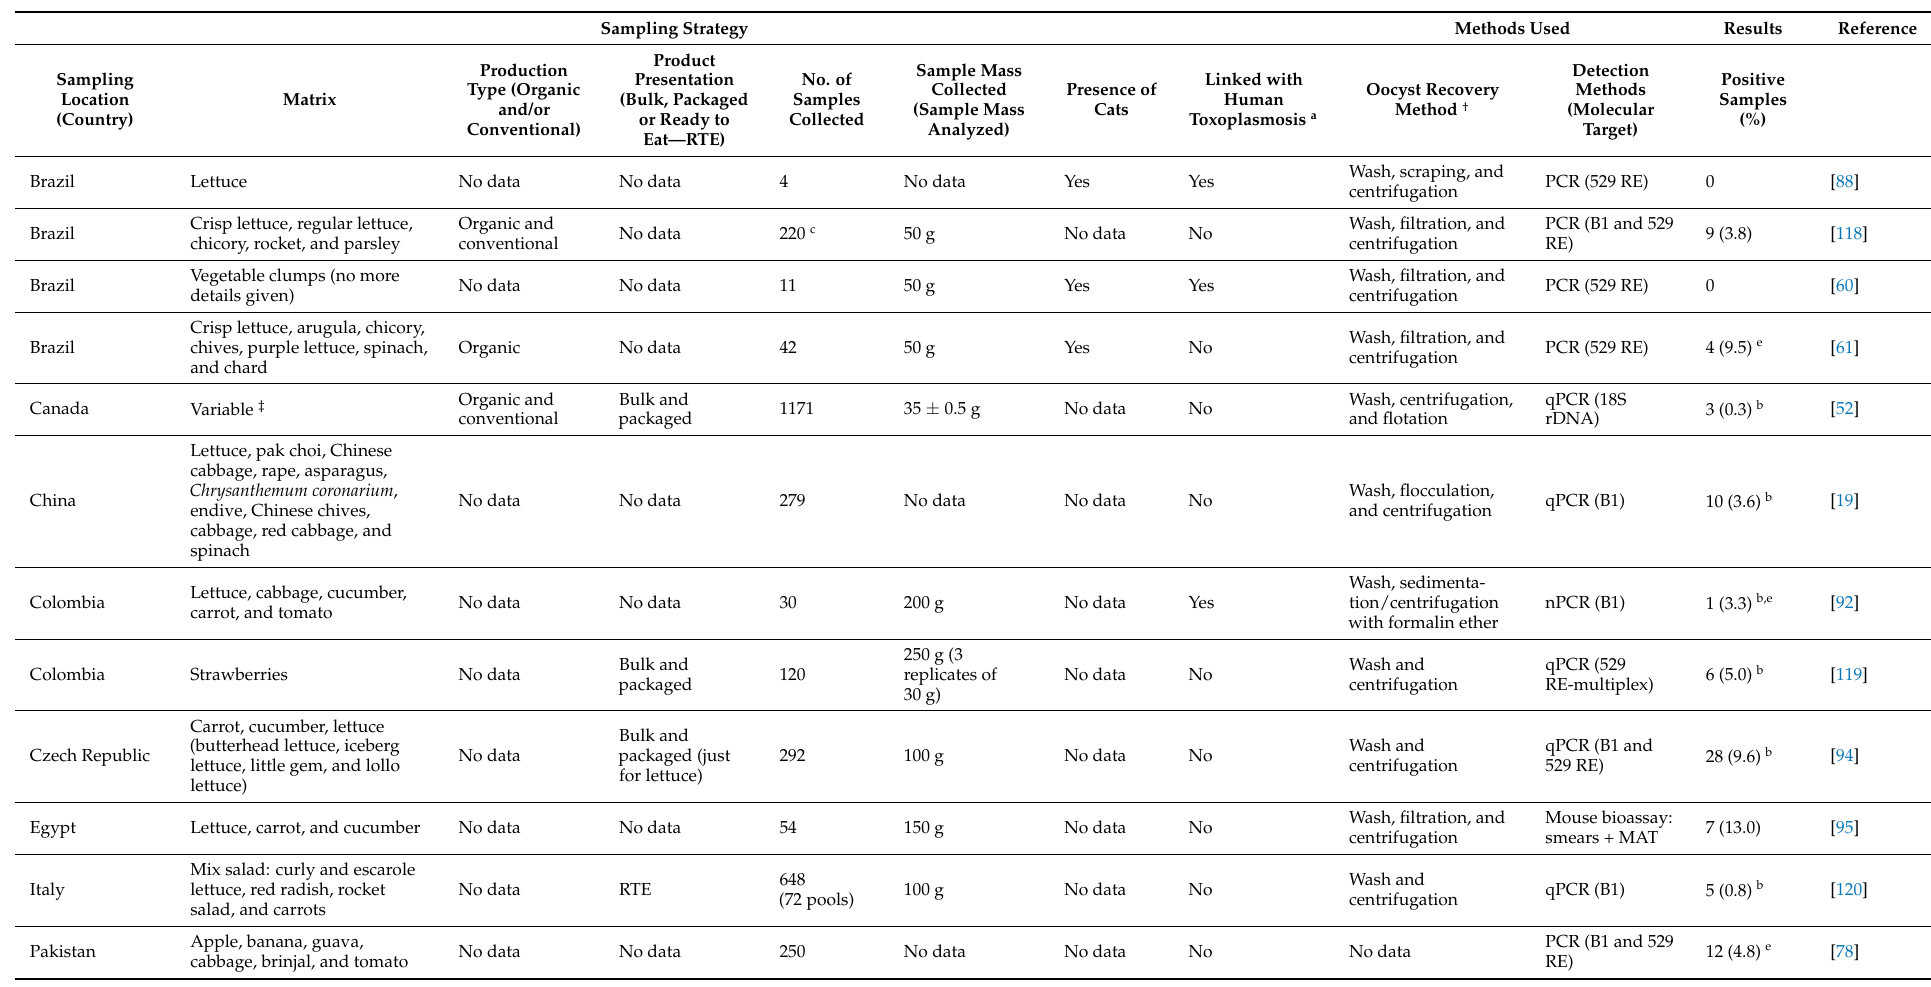
Table 3. Worldwide detection of Toxoplasma gondii oocysts in fresh produce (vegetables and fruit) based on molecular and bioassay methods in articles published up to the end of